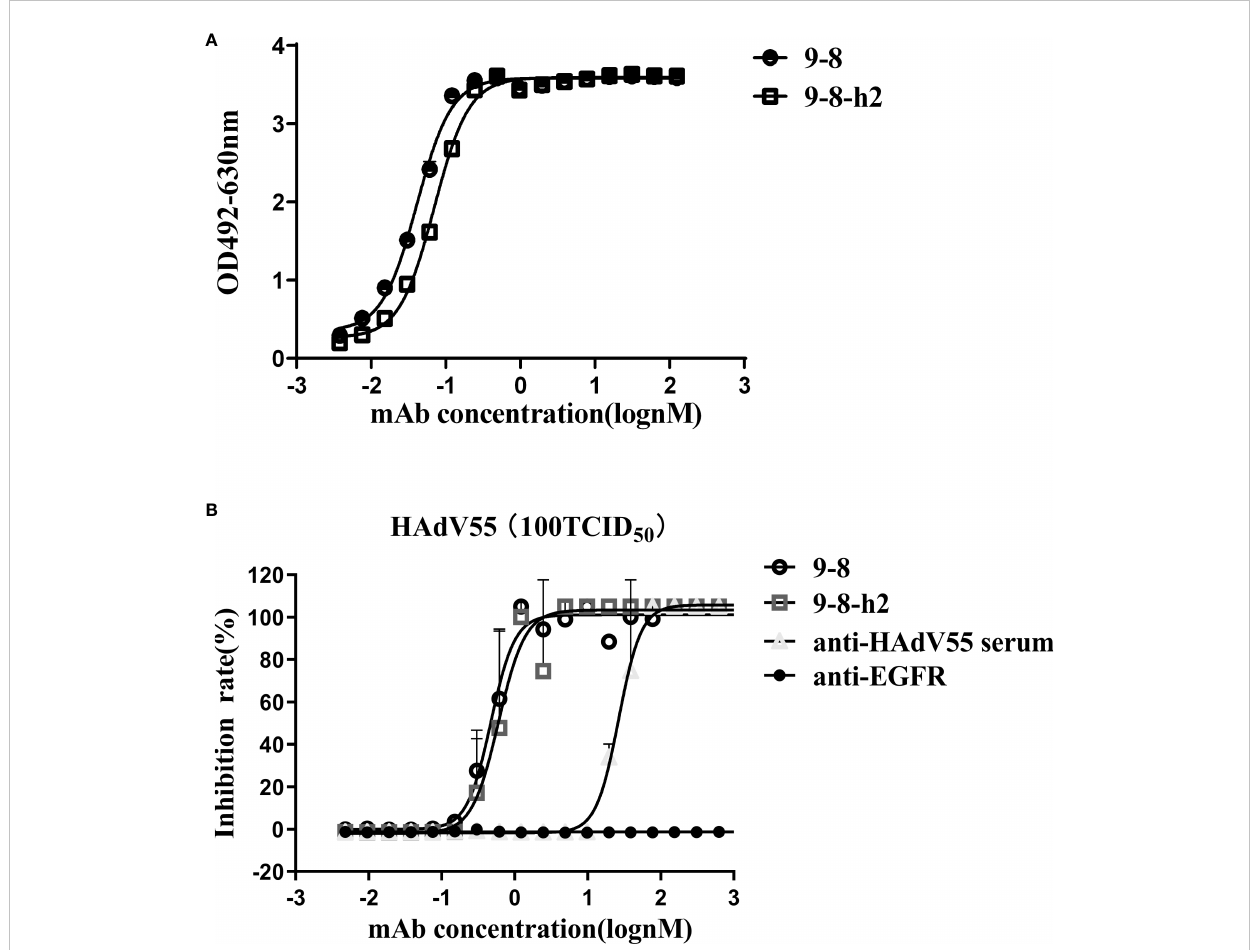
FIGURE 3 Humanized mAb 9-8-h2 binding and neutralization abilities. (A) Humanized mAb 9-8-h2 binding to HAdV55, as assessed using ELISA. (B) Neutralization assay of humanized mAb 9-8-h2. Data are shown as the mean ± SD (n = 3 independent experiments). Nonlinear regression analysis was used to obtain the IC 50